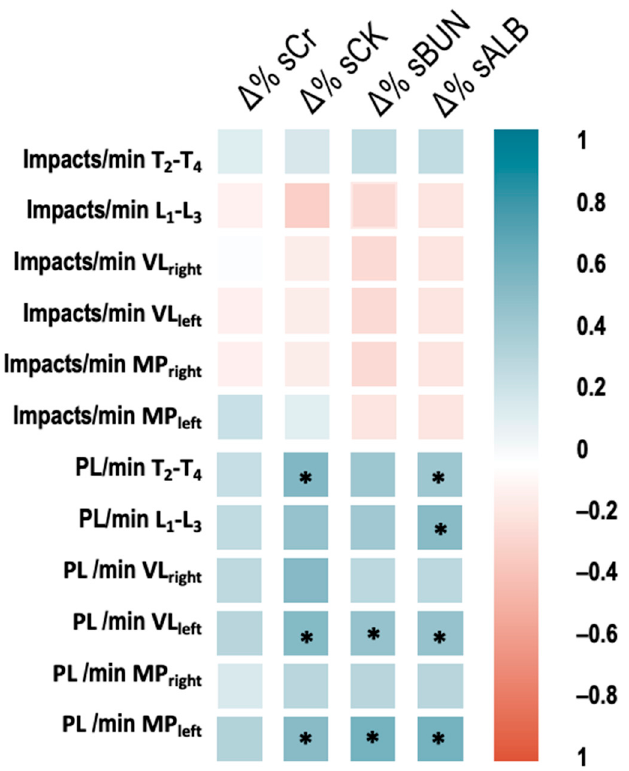
Figure 3. Correlation between percentage of change (pre vs. post0h) of serum values and accelero- metric load (impacts and Player Load). * significant correlation p < 0.05. PL = player load, T 2 –T 4 = thoracic 2nd–4th, L 1 –L 3 = lumbar 1st–3rd; VLright and VLleft = vastus lateralis and MPright and MPleft = malleolus peroneus.